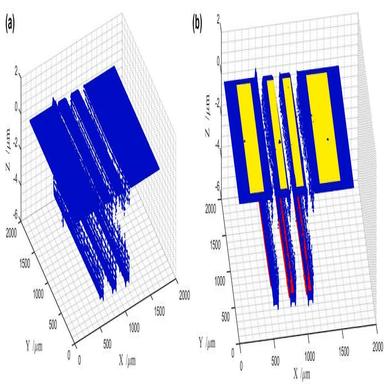
Visualization of the measurement data: (a) The raw data; (b) The evaluation area in red and yellow. (For interpretation of the references to color in this figure legend, the reader is referred to the Web version of this article.)